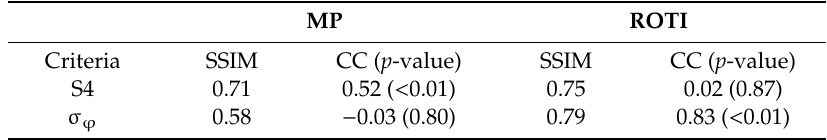
Table 4. SSIM and CC between the maps shown in Figure 7a.